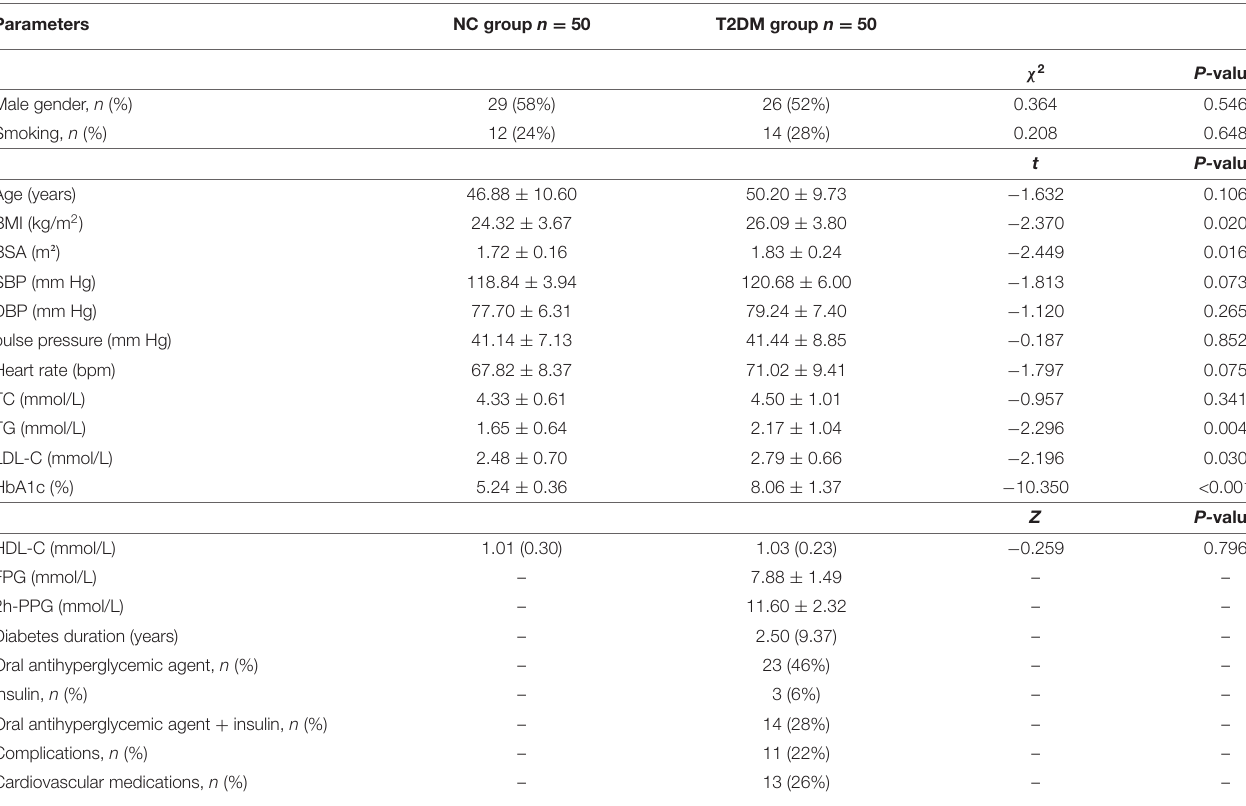
TABLE 1 | Statistical comparisons of demographic characteristics and clinical parameters between NC and T2DM groups. Parameters